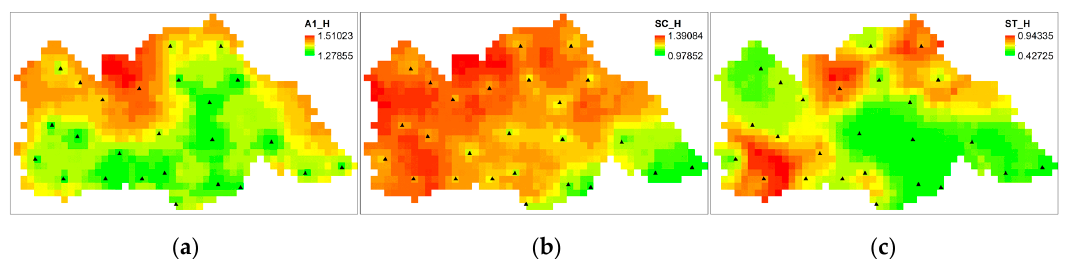
Figure 6. The spatial distribution of marginal entropy based on different discrete methods. ( a ) Statistical results based on the A1 discrete method; ( b ) Statistical results based on the SC discrete method; ( c ) Statistical results based on the ST discrete method.